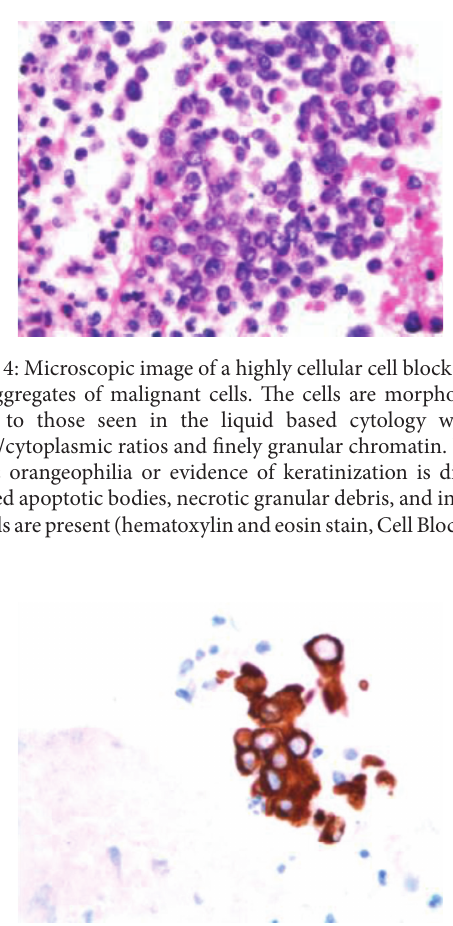
Figure 5: Intense strong cytoplasmic immunoreactivity is present with pancytokeratin (PanCK immunocytochemistry, Cell Block,